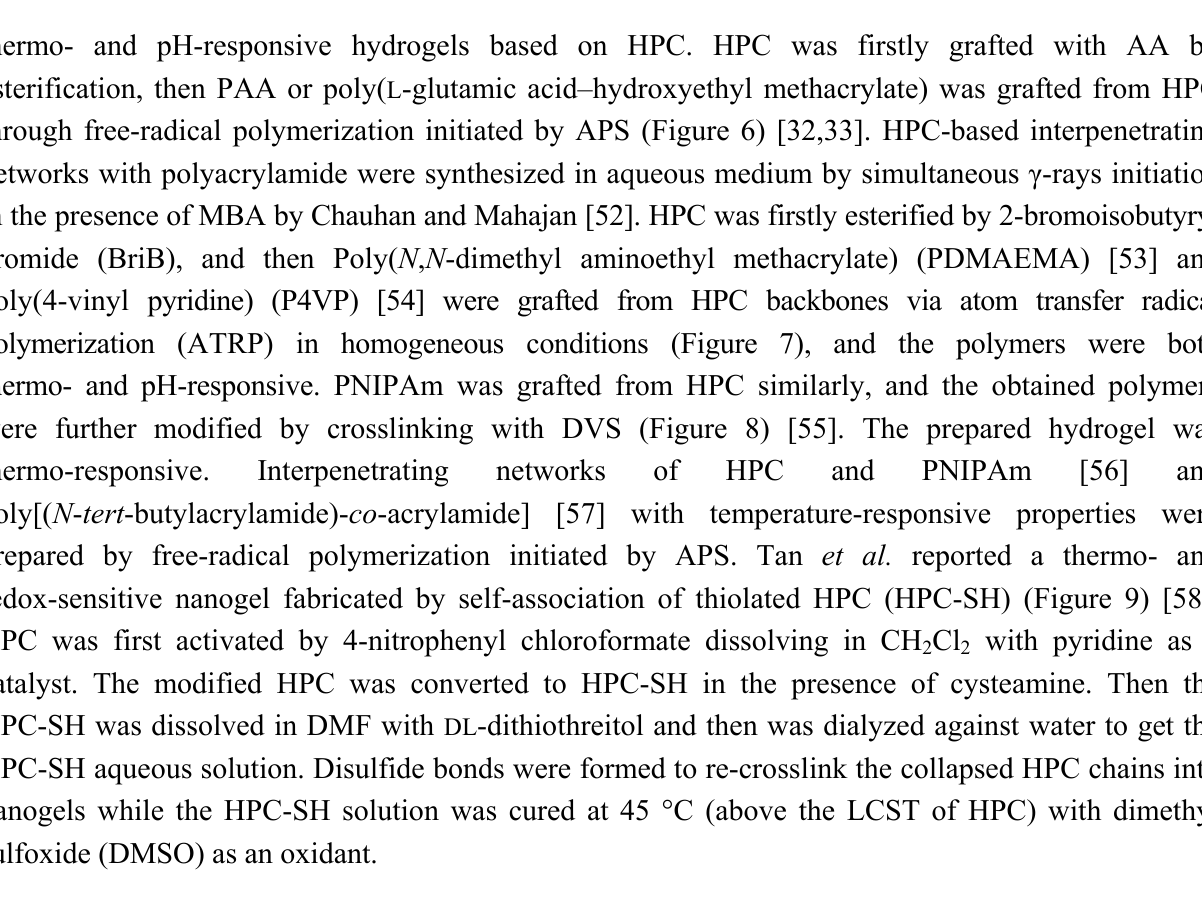
Figure 6. Synthesis route of microgels prepared from hydroxypropyl cellulose (HPC)